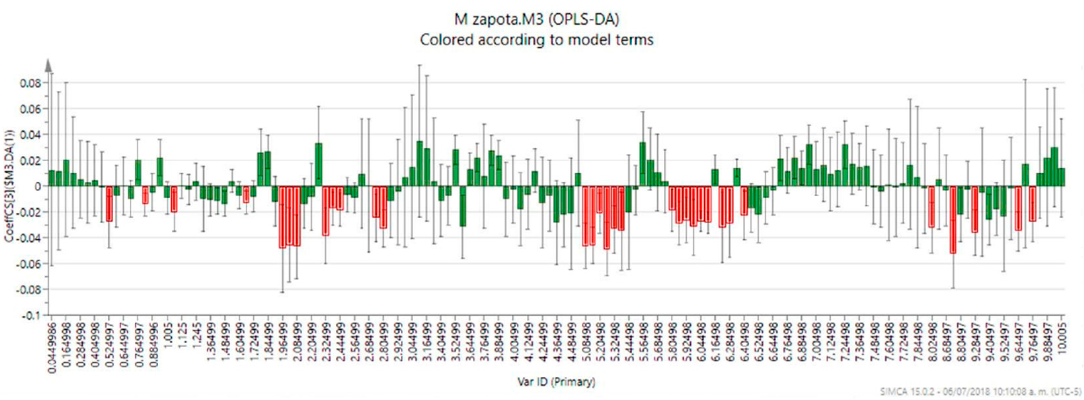
Figure 5. OPLS-DA coefficient plot showing the individual correlation of each bin to the model. Significant bins are shown as red columns.